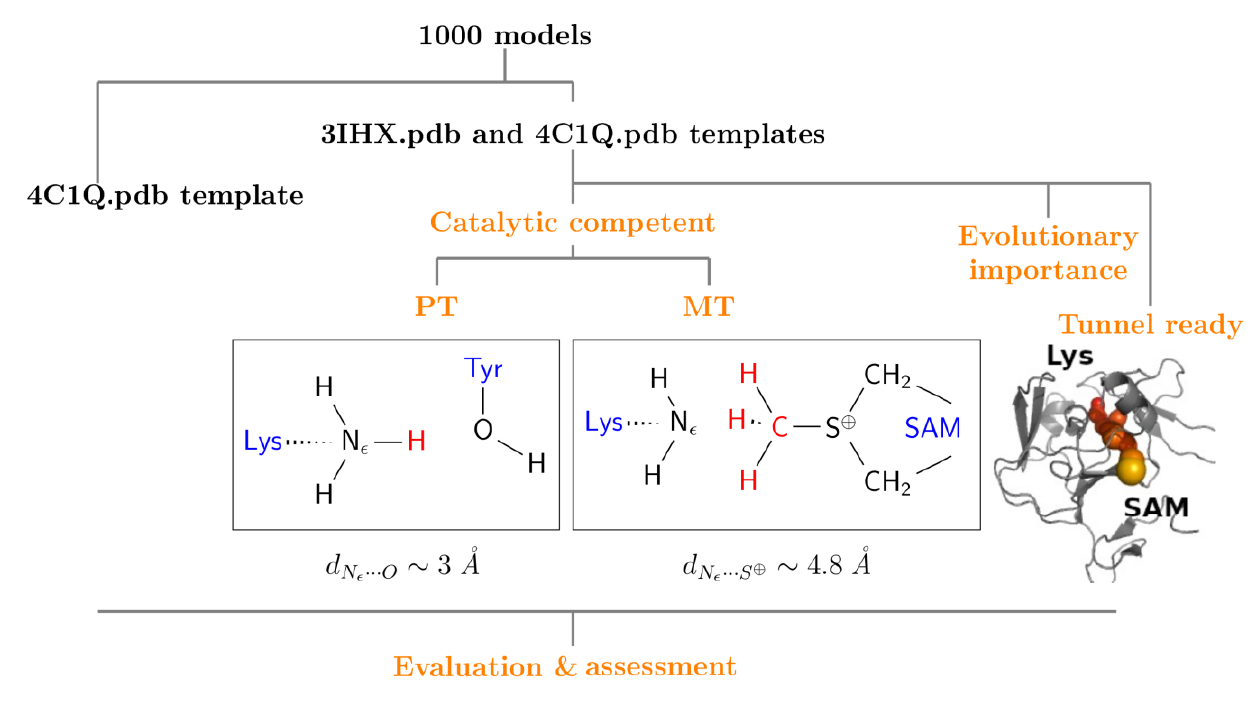
Figure 6. The selection procedure during the homology modeling of PRDM15.